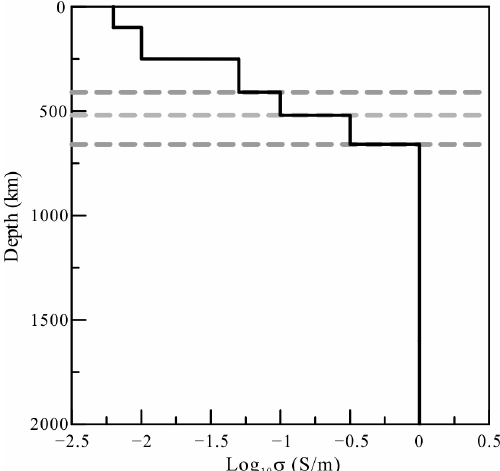
Sensors 2023 , 23 , x FOR PEER REVIEW